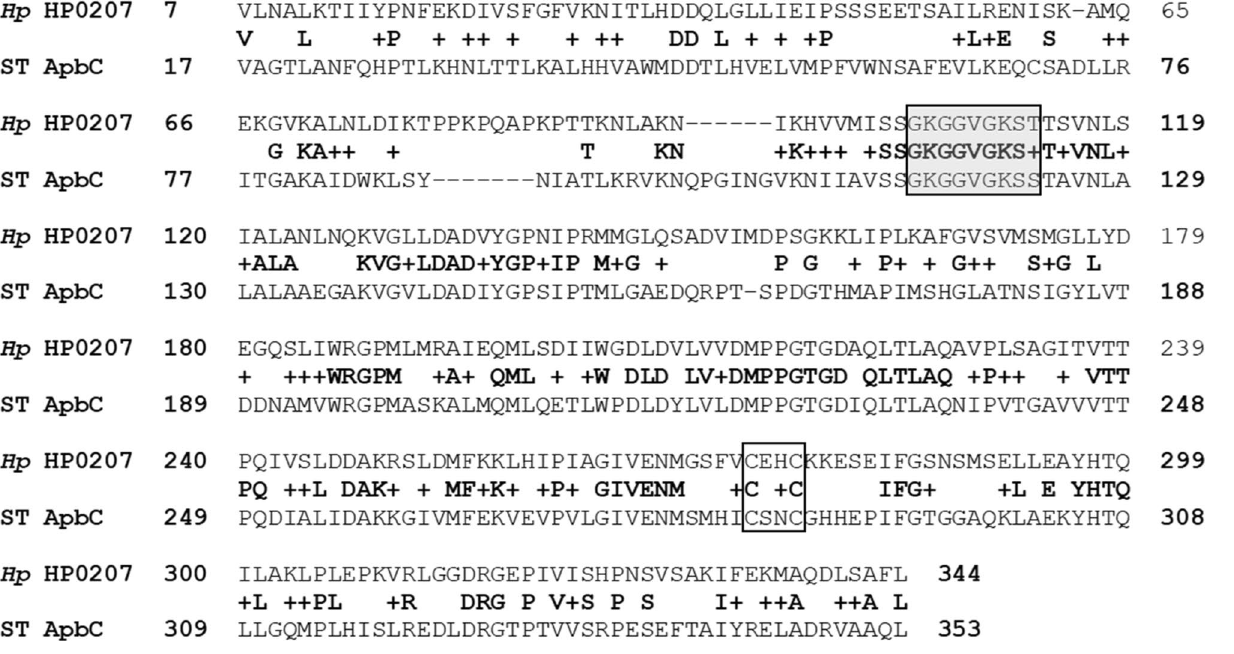
Figure 1. Sequence alignment of H. pylori HP0207 and S. Typhimurium ApbC. H. pylori HP0207 shares 38% identity and 59% similarity with S. Typhimurium ApbC. A deviant Walker A motif involved in ATPase activity is shown in the shaded box. A conserved CXXC motif required for Fe–S binding and in vivo transfer is shown in the white box. The sequence alignment was done using BlastP (https:// blast. ncbi. nlm. nih.